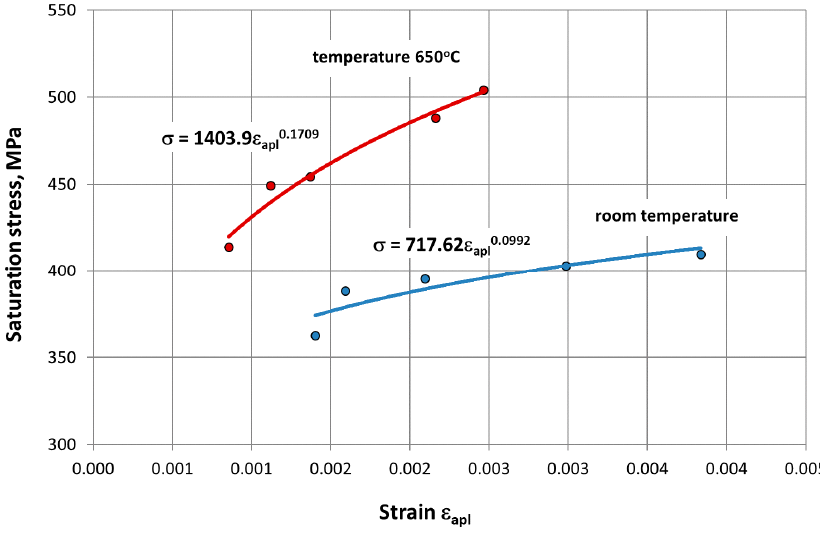
Figure 12. Cyclic strengthening curves for HR6W alloy at room temperature and 650 °C.